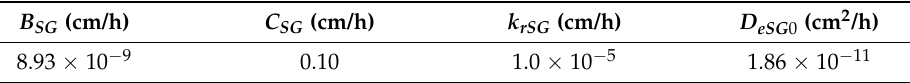
Table 4. Reaction coefficients of the reaction model of slag.